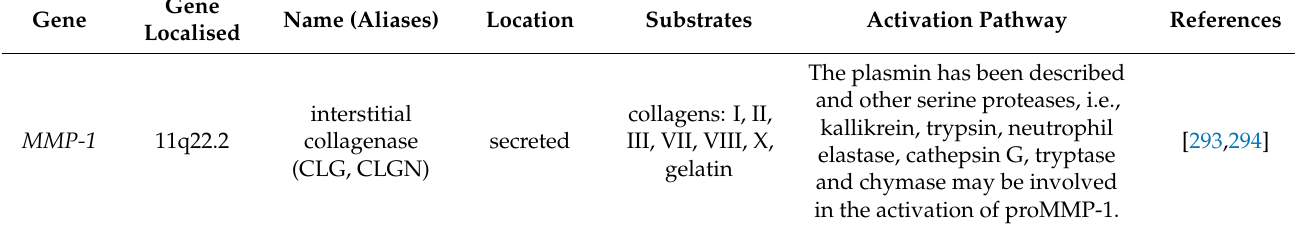
Table 6. Characteristics of MMPs associated with BC